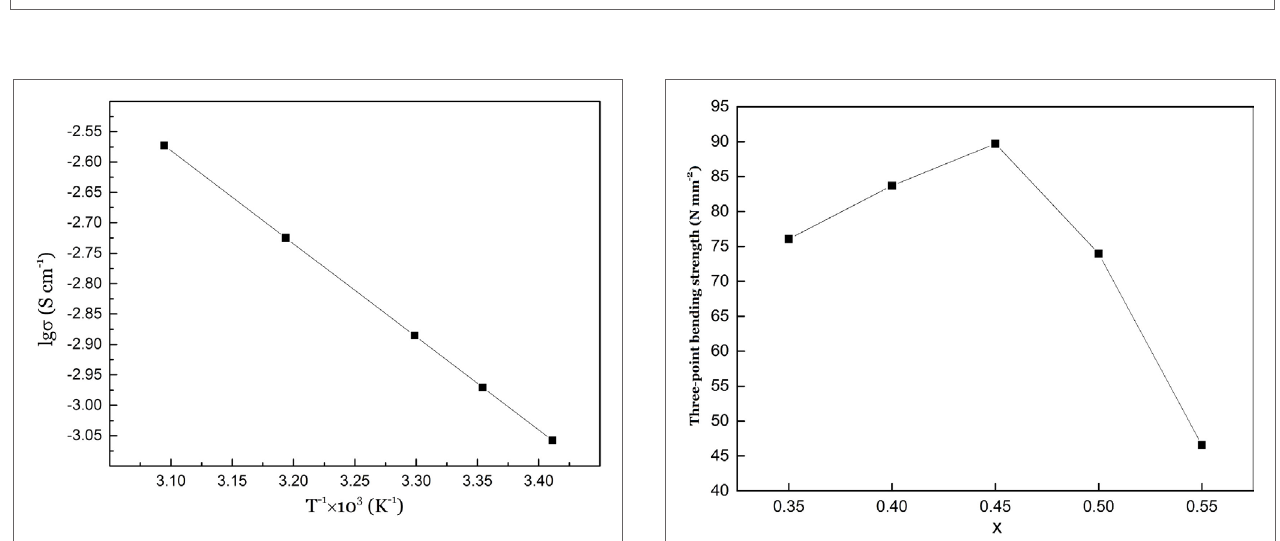
FigUre 7 | Total, bulk, and grain boundary electrical conductivity at 25°c, and relative density of li 1 + x al x ge 0.2 Ti 1.8 − x (PO 4 ) 3 as a function of x .